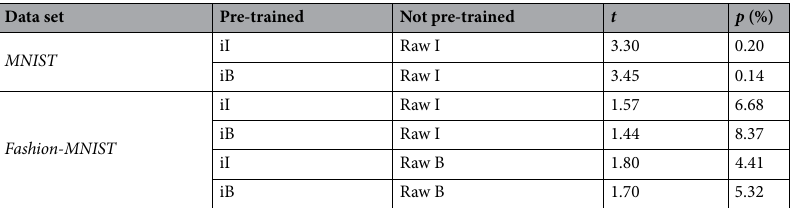
Table 5. Exceptions and alpha value inflation endangered cases for the accuracy t-test for largest decline for not pre-trained pruning by C. elegans . I—iterative pruning, B—bio pruning; i—structure implantation.